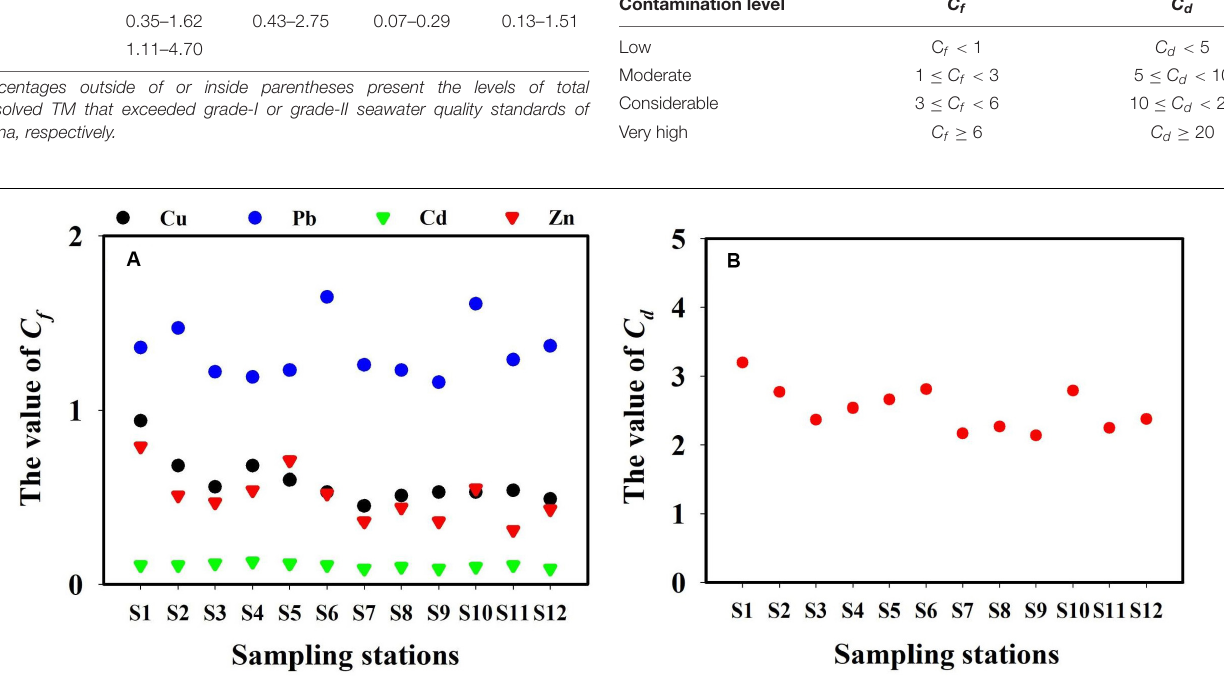
Frontiers in Marine Science |